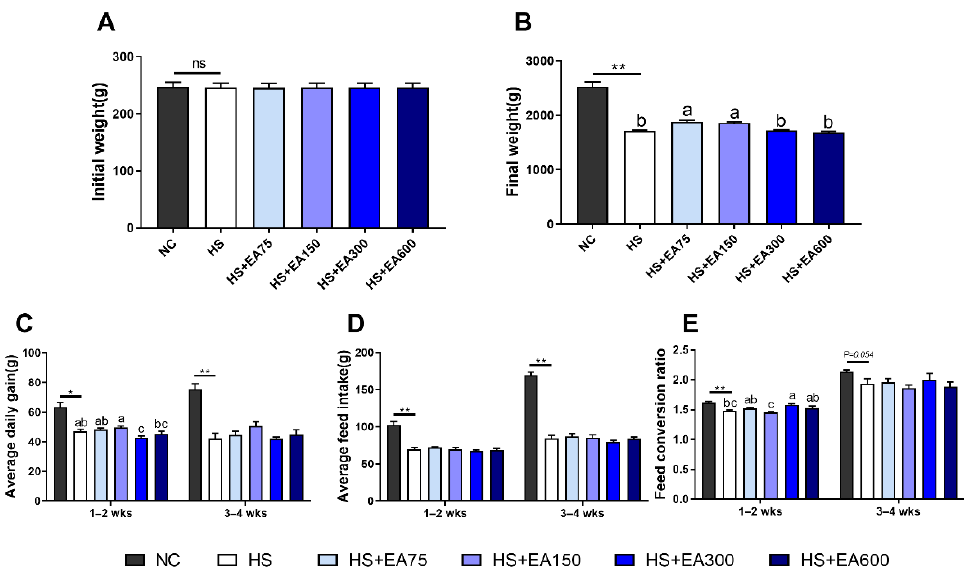
Figure 3. Effects of different levels of EA on the performance of the heat-stressed broilers. ( A ) Initial weight. ( B ) Final weight. ( C ) Average daily gain. ( D ) Average feed intake. ( E ) Feed conversion. Data are presented as mean ± SEM (n = 6). NC (negative control) represents the broilers supplemented with a basal diet at normal temperature (23 ± 2 °C). The broilers in the 5 experimental groups were supplemented with basal diets containing different levels of EA (0, 75, 150, 300, and 600 mg/kg) at HS temperature (35 ± 2 ◦ C), which are represented as HS, HS + EA75, HS + EA150, HS + EA300, and HS + EA600, respectively. Shared superscript letters indicate no significant difference ( p > 0.05). “*” indicate a significant difference between groups ( p < 0.05). “**” indicate a significant difference between groups ( p < 0.01). “ns” indicates a no significant difference between groups where p >